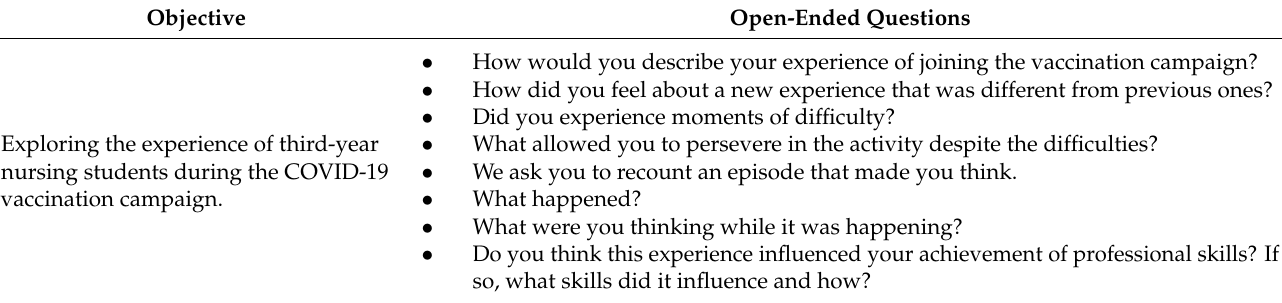
Table 1. Interview outline with IPA